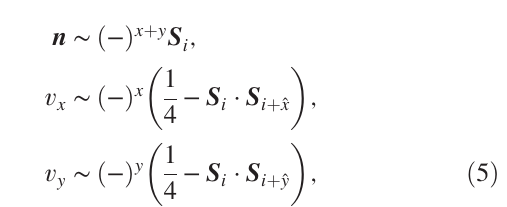
FIG. 6. Two types of PVBS phases. Thick purple links encircle the plaquette on which the spin singlet is formed. A diamond plaquette contains the diagonal bond, while a square plaquette does not. Each type of the PVBS order induces a corresponding lattice distortion. The undistorted lattice is shown as the back- ground for contrast. Depending on the sign of λ 2 , either diamond plaquette or square plaquette PVBS